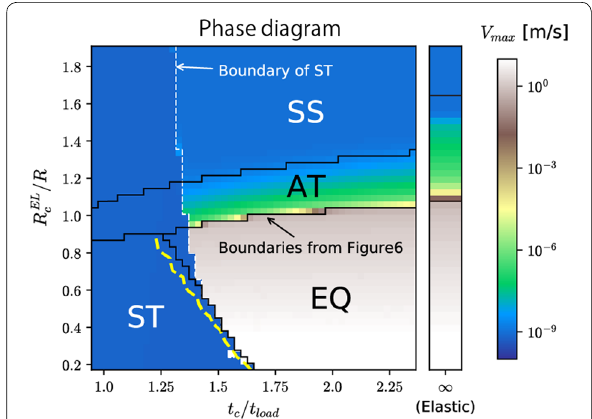
Fig. 10 V max as a function of t c / t load and R EL c / R with a larger initial perturbation V ini = 0.56 V pl . Black lines show the phase diagram from Fig. 6 and the yellow dashed line is calculated from the cases plotted here. The white dashed line indicates the boundary of ST with this initial condition. A large initial perturbation expands the region for ST. Elastic cases ( t c = ∞ ) are shown in a right thin